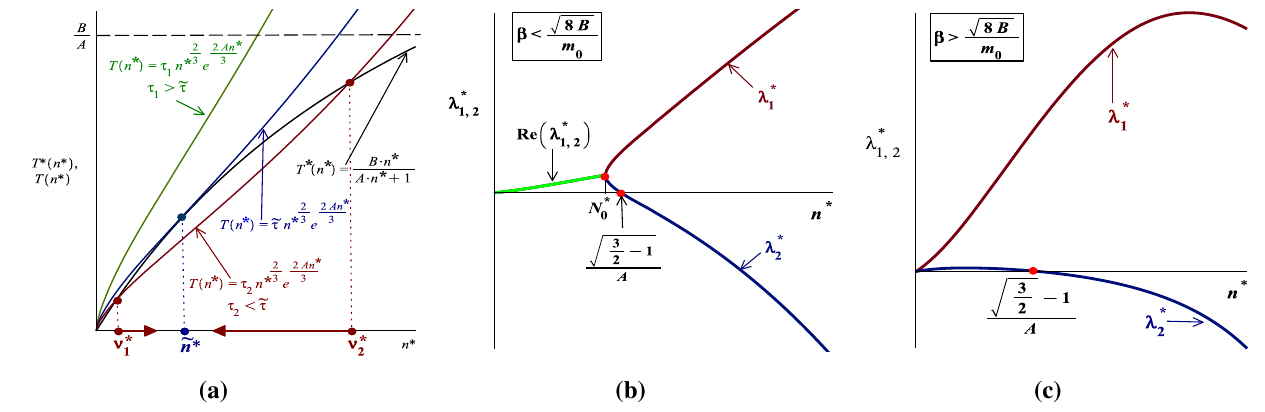
Fig. 2 The critical points of the type ( n ∗ , H ∗ = 0 ) have n ∗ deter- at critical points to the left of (cid:17) n ∗ = ( or with positive real parts (depending on β ), while at critical points to mined by the intersection points of the curve T ( n ∗ ) = τ n ∗ 2 / 3 e 2 An ∗ / 3 the right of (cid:17) n ∗ the eigenvalues are real with λ ∗ with the curve T ∗ ( n ∗ ) = Bn ∗ /( 1 + An ∗ ) . These are: only the origin, √ √ −√ – negative (see b and c ). Given that one of the eigenvalues is always 2 / 3 A − 1 / 3 B ; the origin and 2 / 3 ( 3 / 2 − 1 ) 1 / 3 e 2 / 3 when τ > (cid:17) τ = √ positive or has positive real part, critical points ( n ∗ , H ∗ = 0 ) are never (cid:17) n ∗ = ( 3 / 2 − 1 )/ A when τ = (cid:17) τ ; and the origin and ν ∗ when τ < (cid:17) τ 1 , 2 → (cid:17) n ∗ when τ → (cid:17) τ from below) – a . The eigenvalues λ ∗ (with ν ∗ 1 , 2 1 , 2